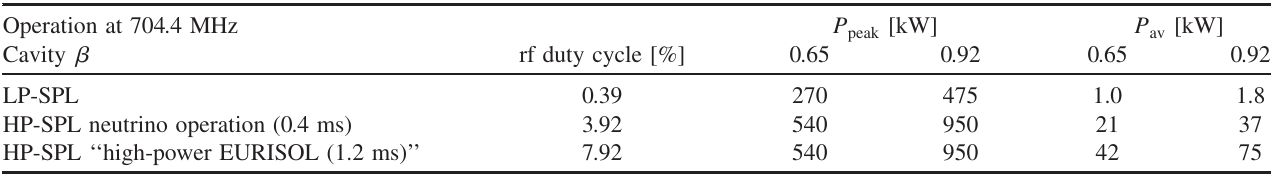
TABLE XVIII. Maximum rf power per cavity when operating at 704.4 MHz. Operation at 704.4 MHz